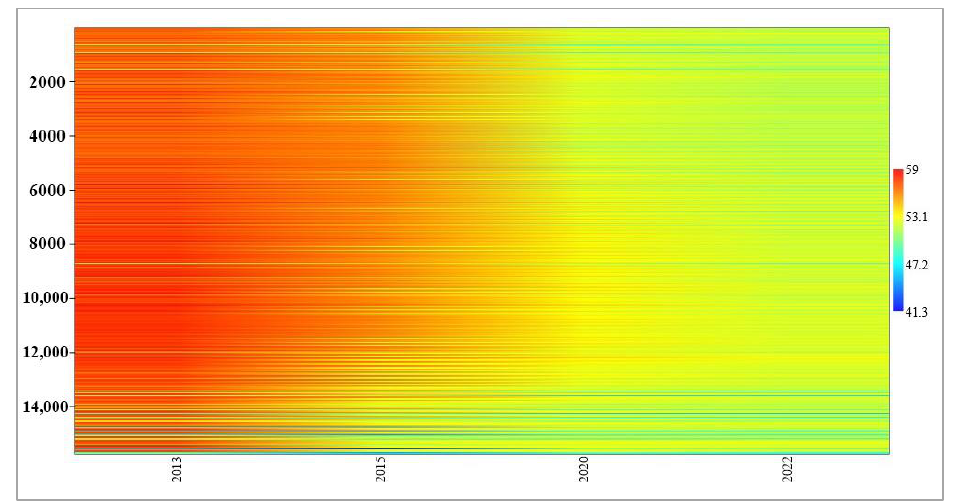
Figure 10. Matrix plot of land surface Temperature (LST) changes in the studied area (15,730 pixels) during the years 2013, 2015, 2020 and 2022 (masked by the built green town extent).